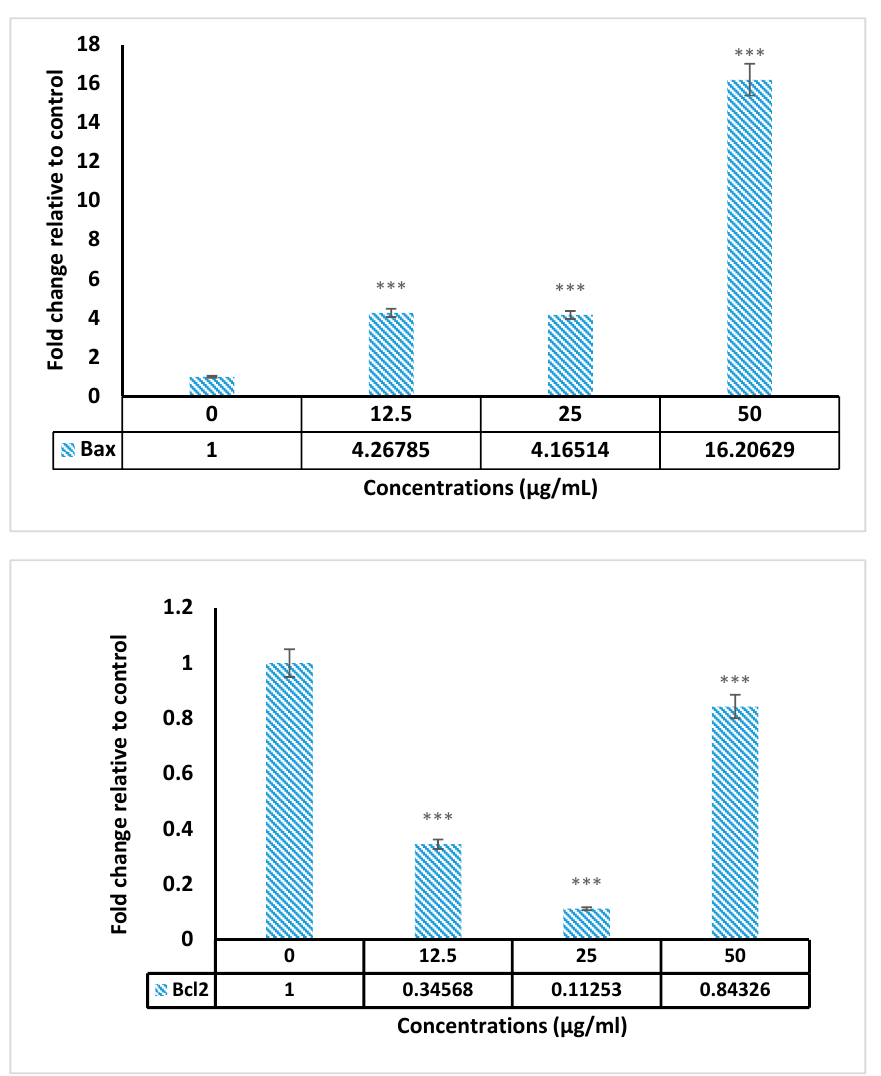
Figure 6. The Bax and Bcl-2 gene expression of MCF-7 cells treated with 12.5, 25 and 50 µg/mL PVLH-EAE. (***: p value < 0.001).